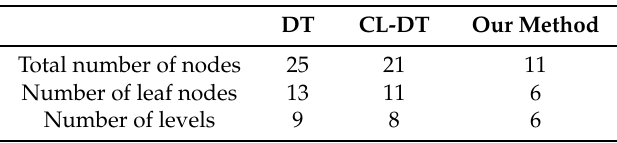
Table 23. Comparison of the induced decision tree parameters.